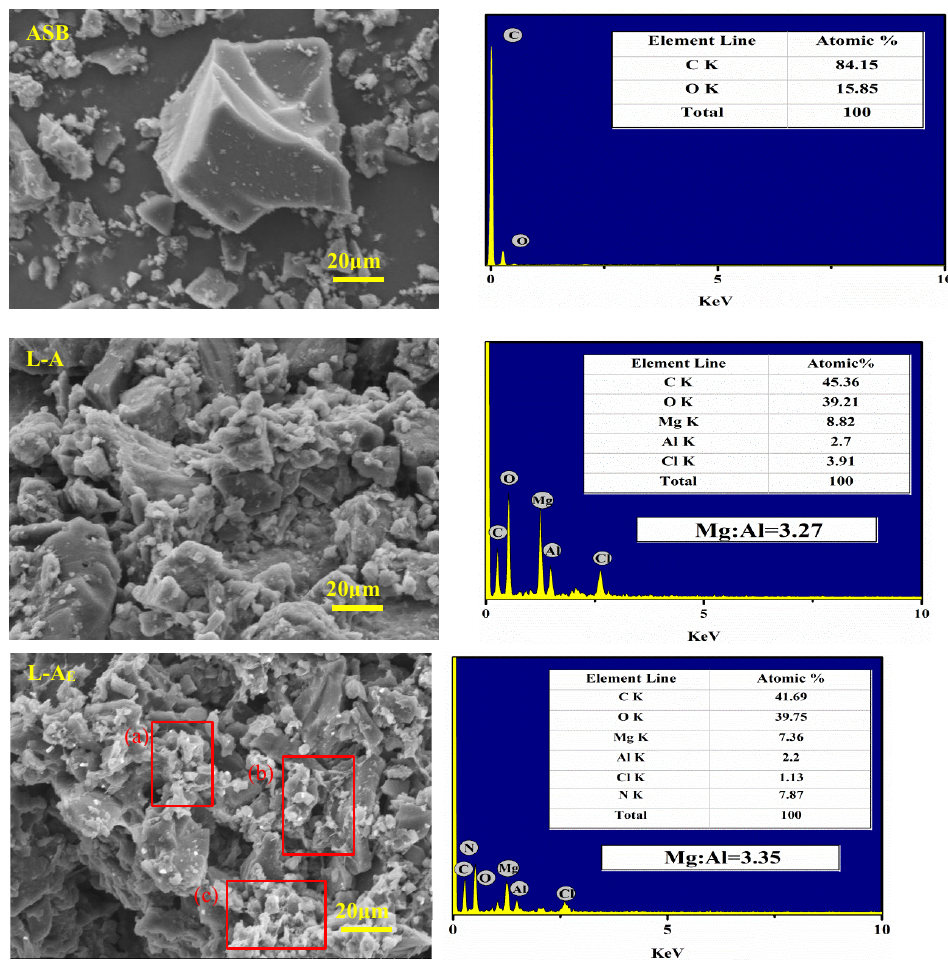
Figure 2. SEM/EDS analysis of the materials (red rectangles (a), (b) and (c) indicate that filament-like adhesion structures were formed in this